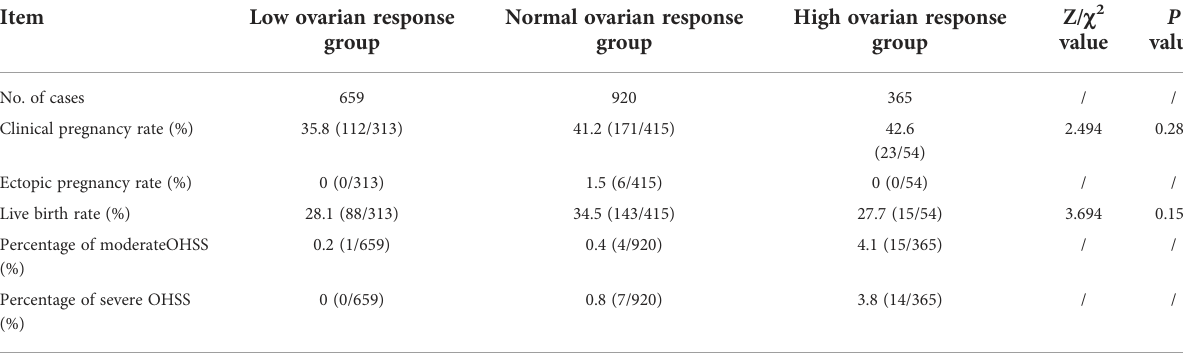
TABLE 2 Indicators related to COH outcomes in patients with different ovarian